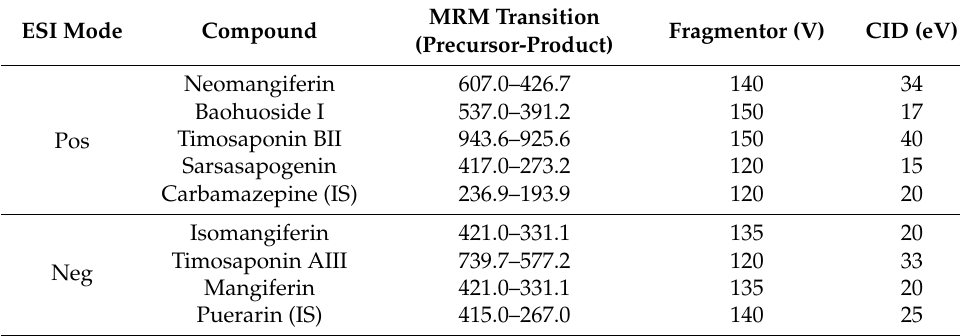
Table 5. MS parameter of seven components of AR and